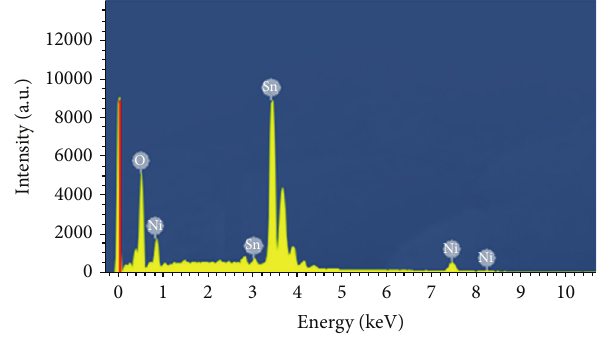
Figure 3: EDS spectrum of NiO/SnO 2